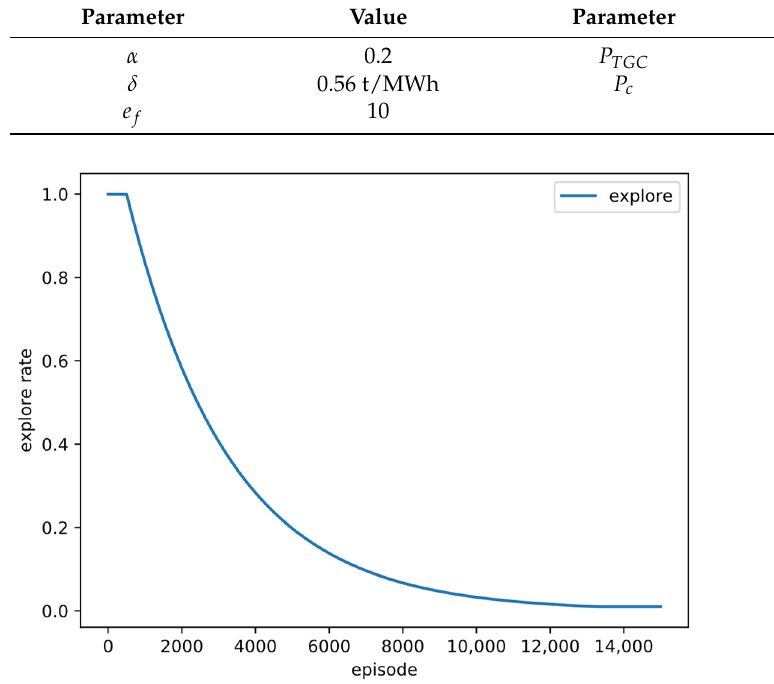
Figure 5. Noise variation added by system action parameters .